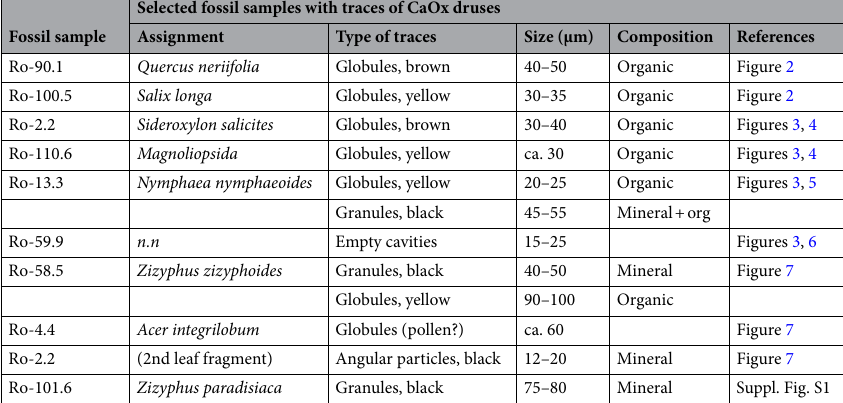
Table 1. List of selected fossil samples with granular structures (traces of CaOx druses).